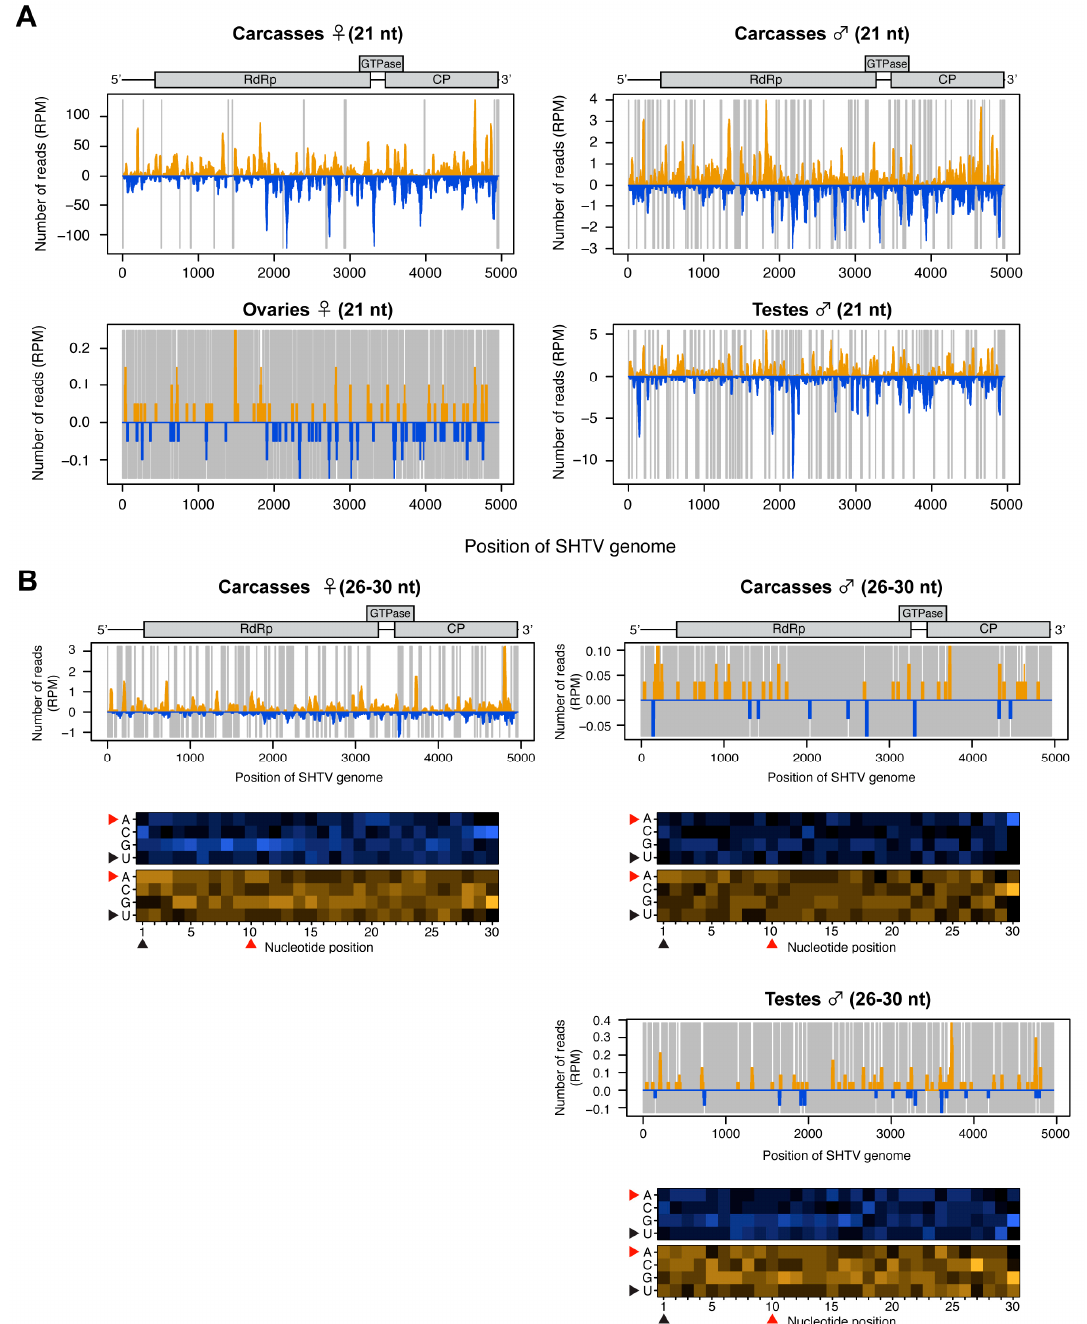
Figure 4. Small RNA responses to SHTV in female and male Ae. albopictus reproductive tissues and carcasses. The distribution of siRNA (21 nt) ( A ) and piRNA-like small RNAs (26-30 nt) (upper panel, B ) mapped to the SHTV genome. A schematic illustration of the SHTV genome is shown on top of small RNAs mapping to the viral sequence. Yellow and blue bars represent positive- and negative-stranded reads, respectively. Regions with no coverage are indicated by gray lines. For 26-30 nt SHTV-derived piRNA-like small RNAs, relative nucleotide frequency at each position is shown as a heat map (lower panel in B ) in which the color intensity denotes the frequency. 26-30 nt small RNA reads were not detected in ovary samples ( B ). The black and red arrowheads point to the 1U and 10A positions,